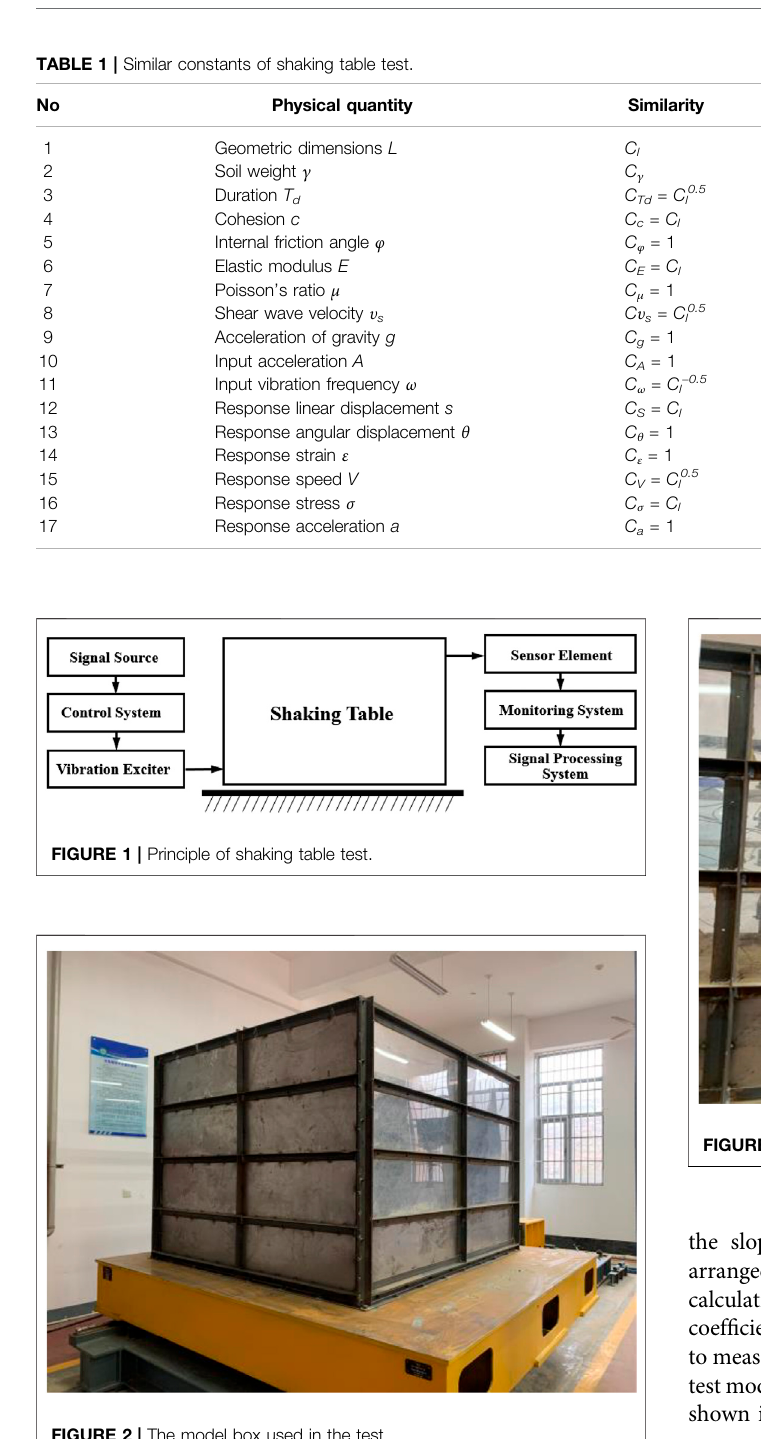
FIGURE 2 | The model box used in the test.